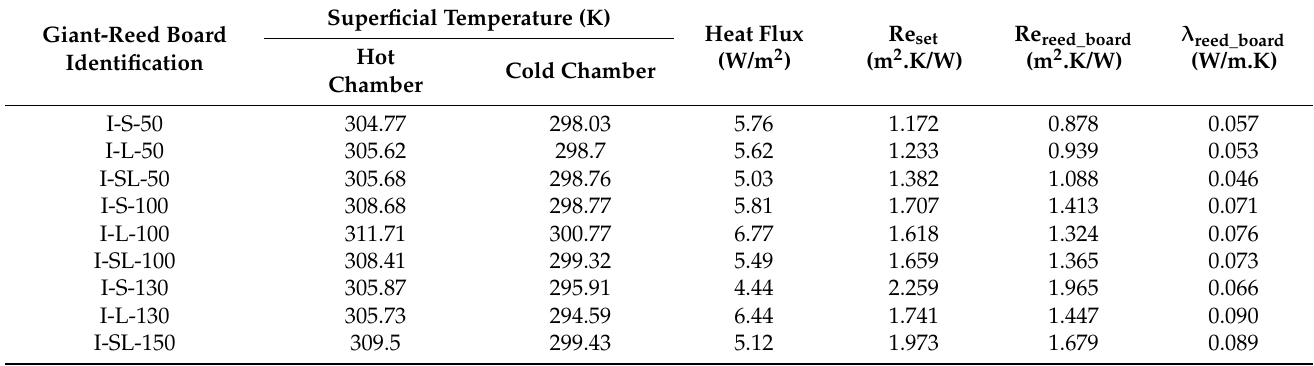
Table 6. Average values of the studied thermal parameters: giant-reed boards from Region